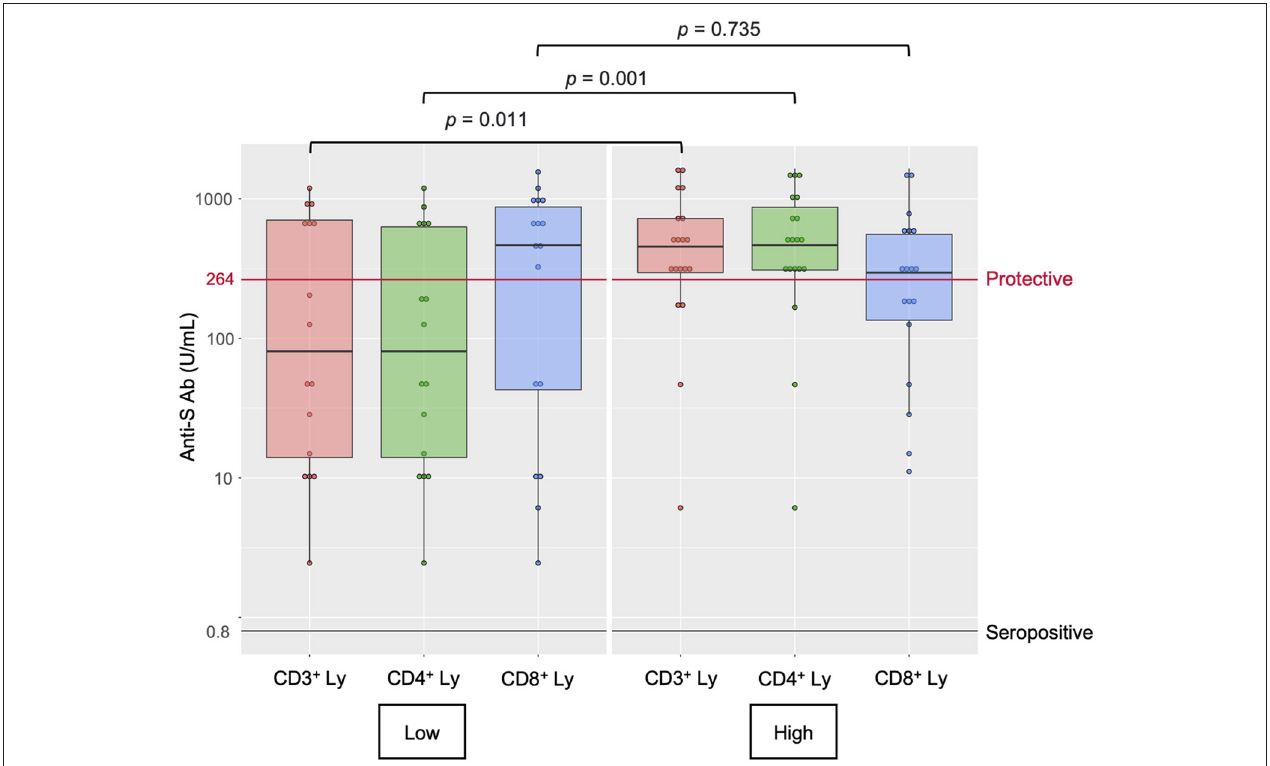
FIGURE 2 | Lymphocyte subset counts and antibody response after two doses of SARS-CoV-2 vaccine in MPN patients. Anti-S Ab, anti-spike-receptor binding domain antibody, Ly, lymphocytes.